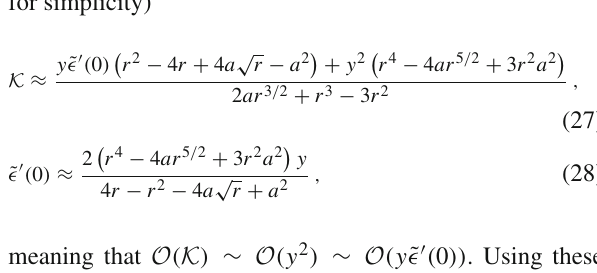
Fig. 3 The contours of constant ISCO (solid black) for the circular motion in the ( a , | (cid:2) | ) parameter space. On the ISCO, we calculate con- stant | y c | and show them with dashed red curves ( | y c | = 0 . 1, 0 . 2, and 0 . 3 from left to right). The vertical gray dashed lines show the constant ISCO for Kerr black holes. The magenta curve indicates the parameter space where the naked singularity starts to appear at the pole. The blue solid (purple dashed) curve indicates the parameter space where ISCO islocatedonthenakedsingularity(ergosurface).Theregionontheright of the blue curve is